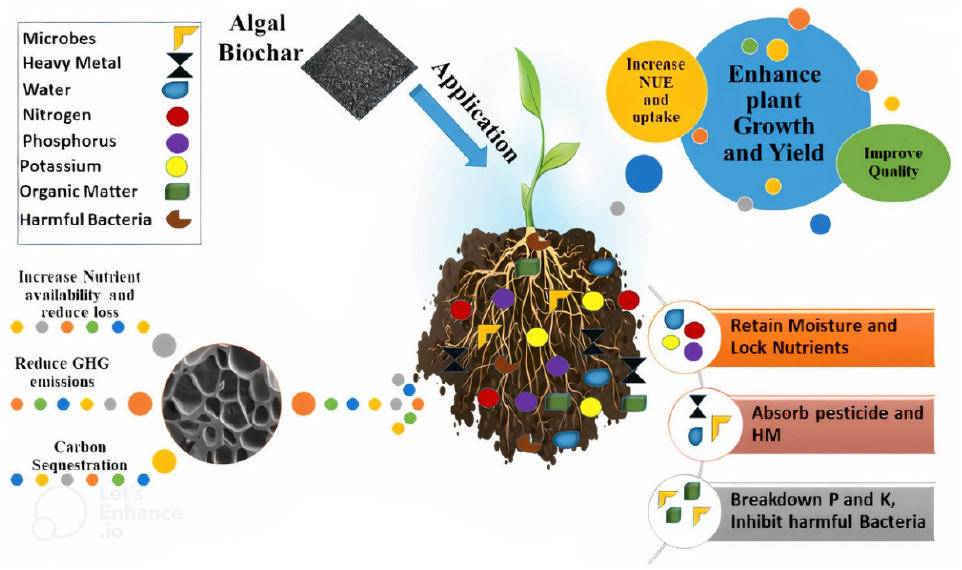
Figure 3. Prospects of algal biochar application in agricultural fields for sustainable development.